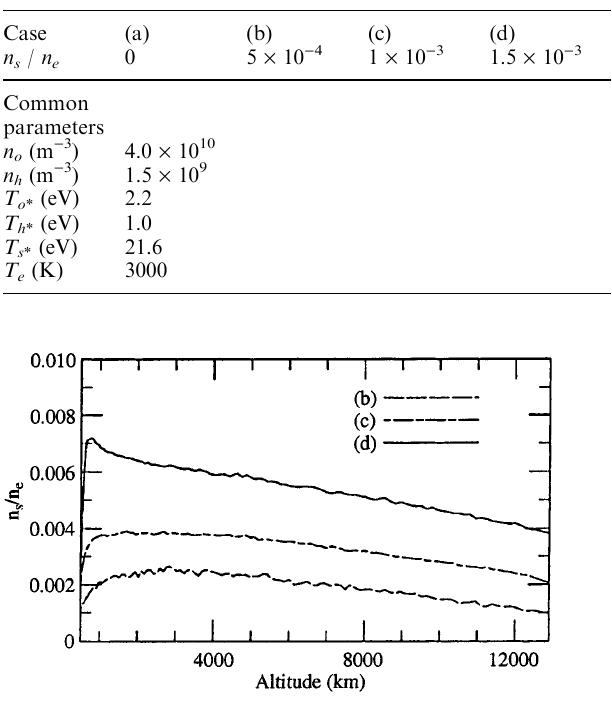
Table 3. Boundary conditions for the four cases with di(cid:128)erent relative photoelectron density. Other parameters are common to these cases: n (O + density), n (H + density), T , T , T , (energy o h o* h* s* spread of the initial O + , H + , and photoelectron distribution), and